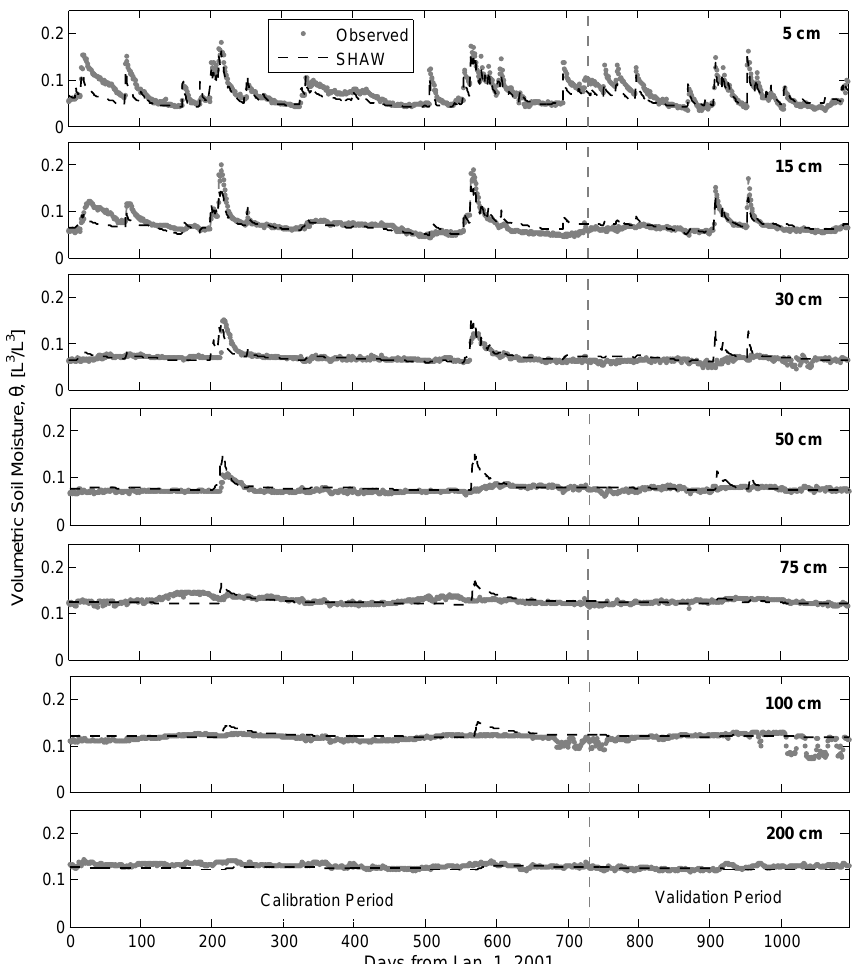
Figure 2. Observed vs. SHAW-simulated volumetric soil moisture [L 3 L − 3 ] at Site 1.